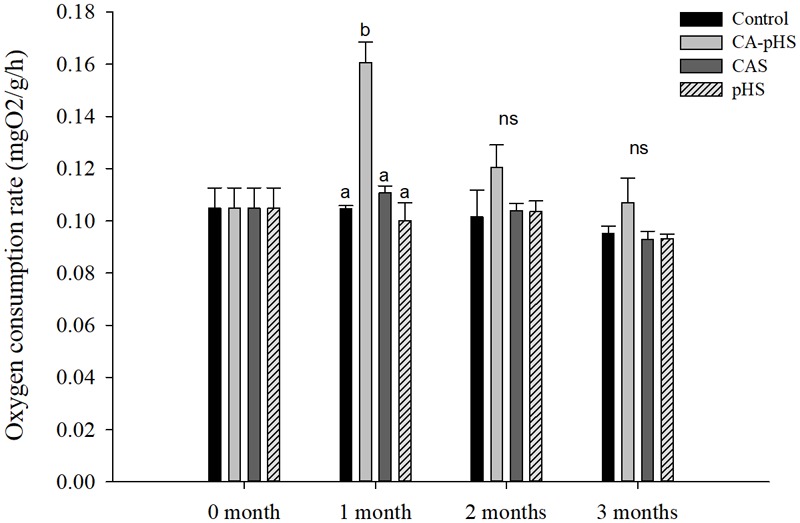
juvenile of S. constricta oxygen consumption rate in the long-term toxicity test. Bars (mean ± SE, n = 3) with different letters denote significant differences (p < 0.05) among the four groups in each month. The letters “ns” indicate insignificant difference among the four groups in each month.